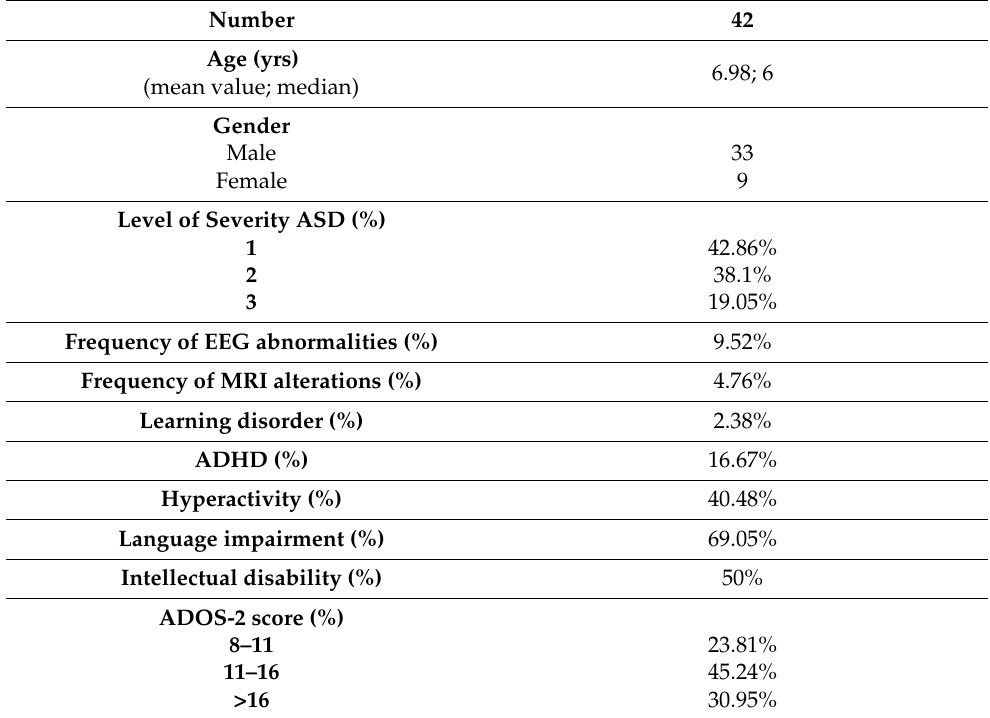
Table 1. Sociodemographic and clinical features of ASD patients.